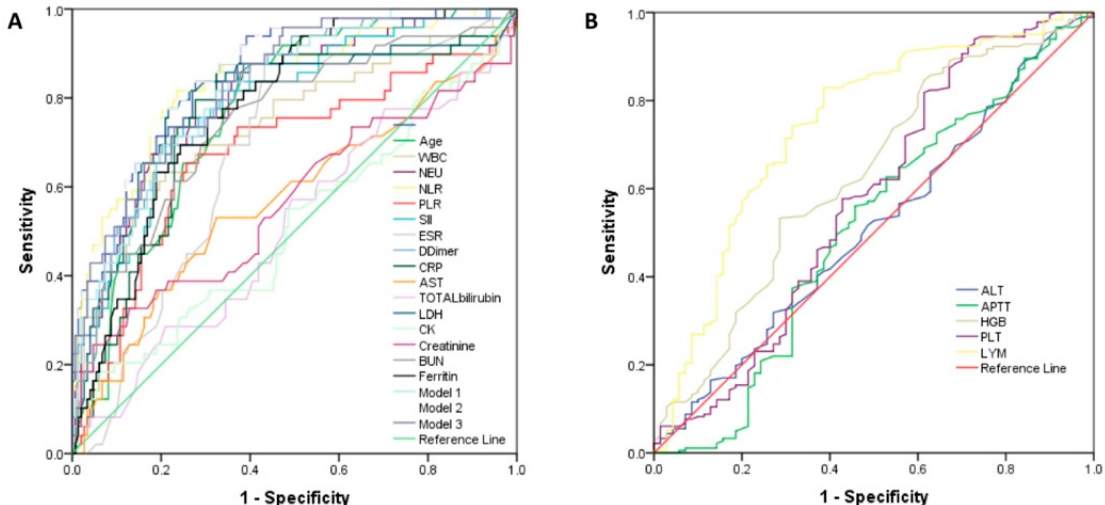
Figure 5. Receiver operating characteristic (ROC) curves for the individual laboratory parameters and models for prediction of disease severity. ( A ) The analysis of AUCs (area under the curve) for age, WBC, NEU, NLR, PLR, SII, ESR, D-dimer, CRP, AST, total bilirubin, LDH, CK, creatinine, BUN, ferritin, and models 1–3; ( B ) ALT, APTT, HGB, and LYM.